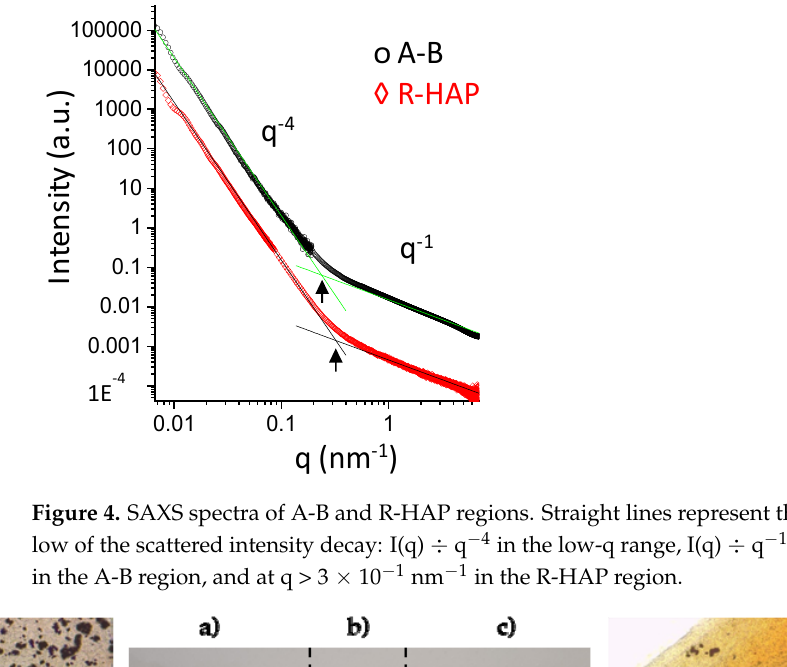
Figure 5. Optical images of Alizarin Red staining of the tubular scaffold: a) R-HAP part; b) inter- face; c) A-B part.